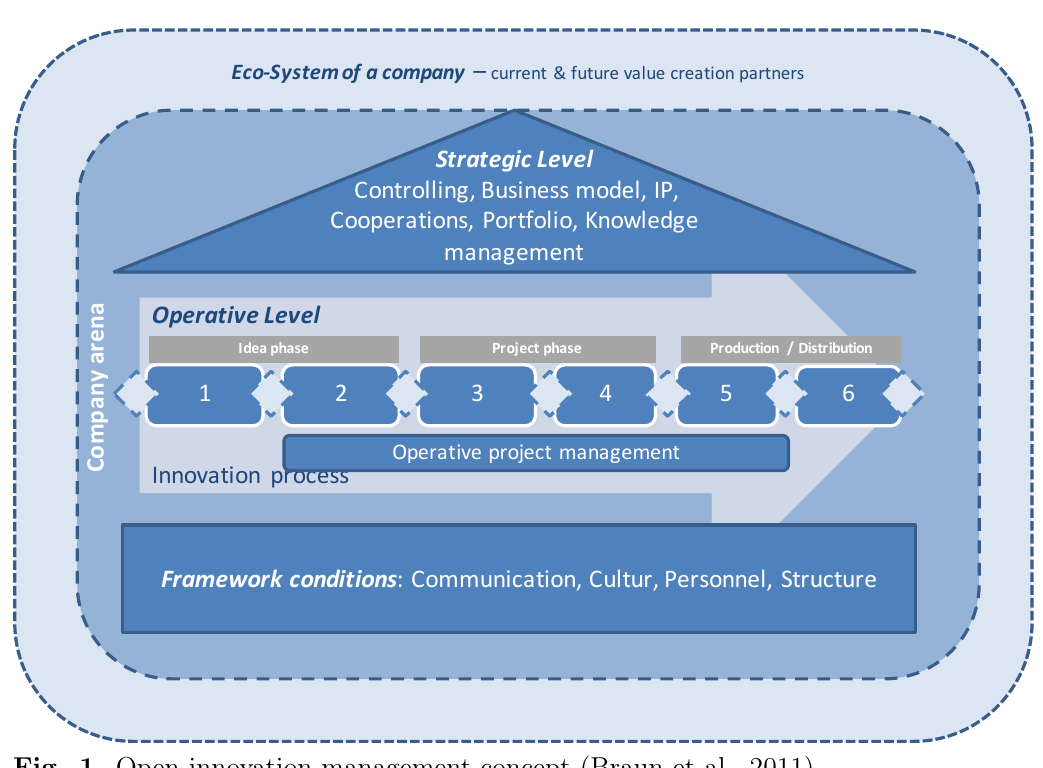
Fig. 1. Open innovation management concept (Braun et al.,